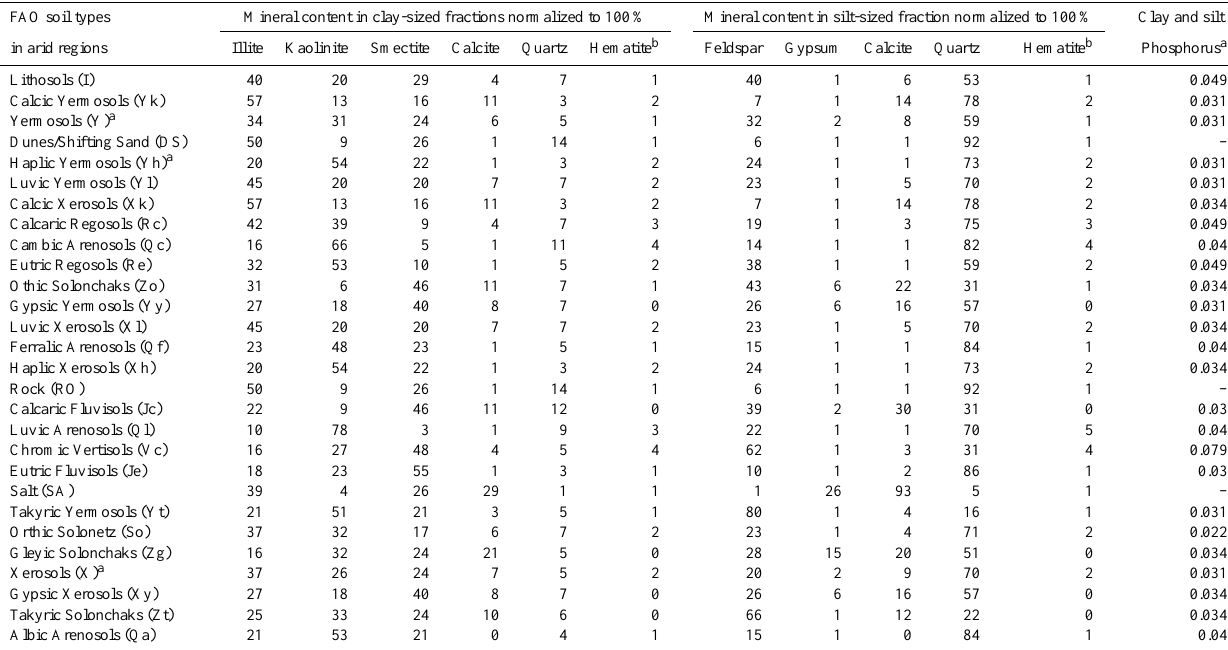
Table 1. Mineral content in clay and silt-sized fractions in selected soil types. FAO soil types Mineral content in clay-sized fractions normalized to